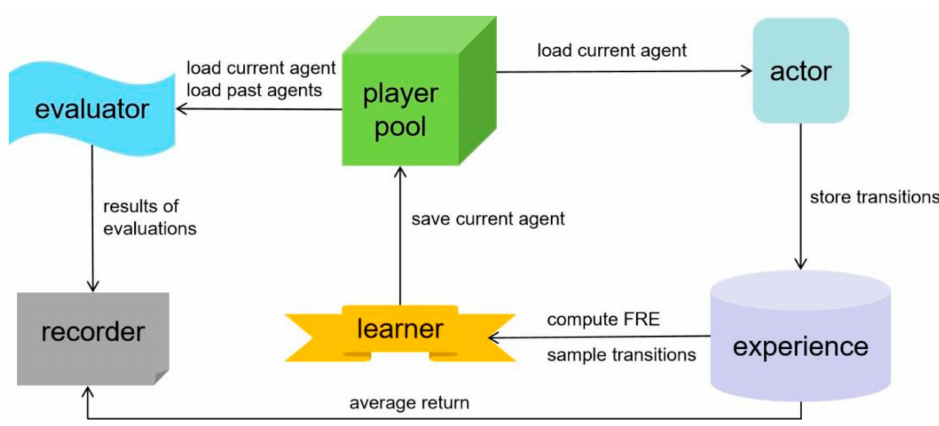
Figure 2. Air Combat Agent Training